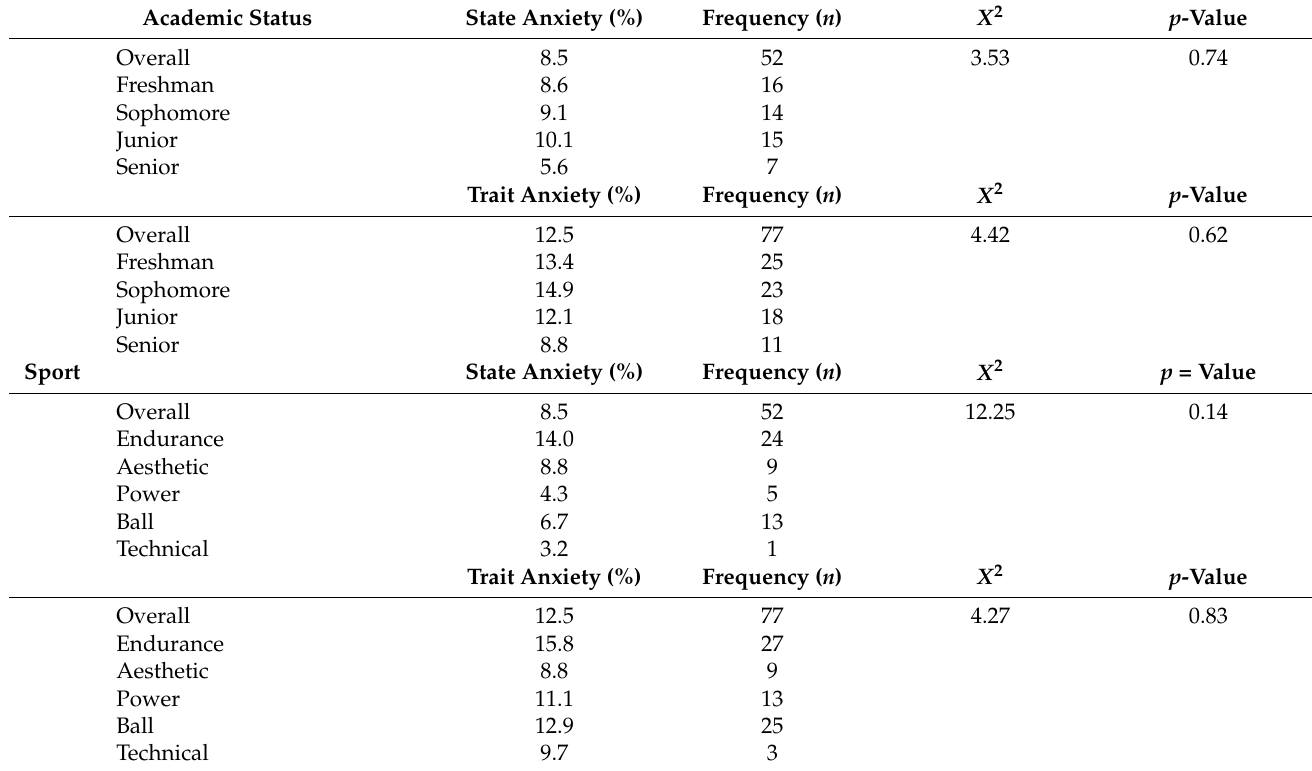
Table 5. Anxiety Prevalence by Academic Status and Sport.